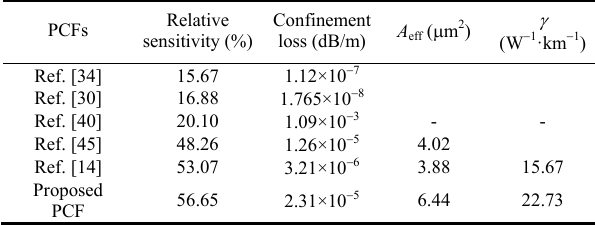
Table 2 Comparison of simulated results among proposed PCF and prior PCFs at 1.33  m